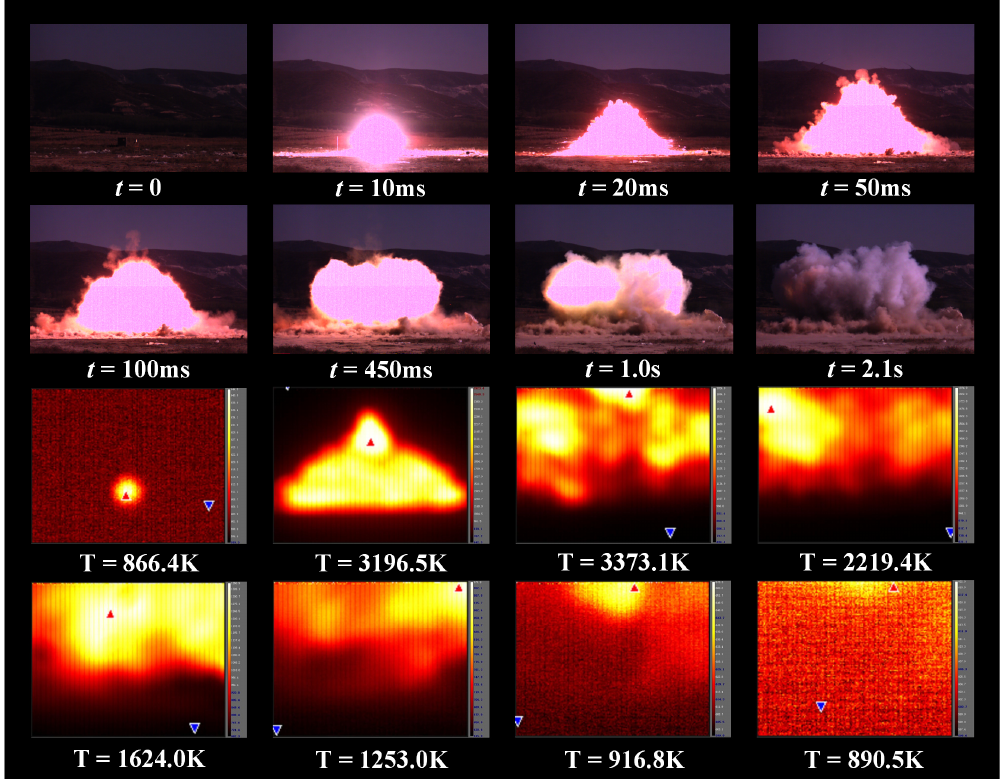
Figure 4. Temperature measurement for the detonation process of